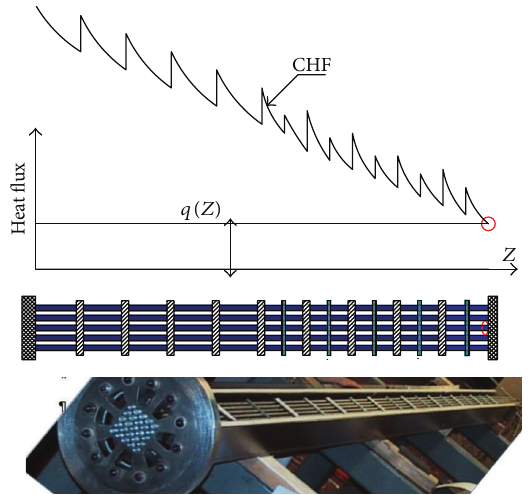
Figure 1: Rod bundle CHF with uniform axial power distribution. (CHF mostly occurs at the end of heated length.)